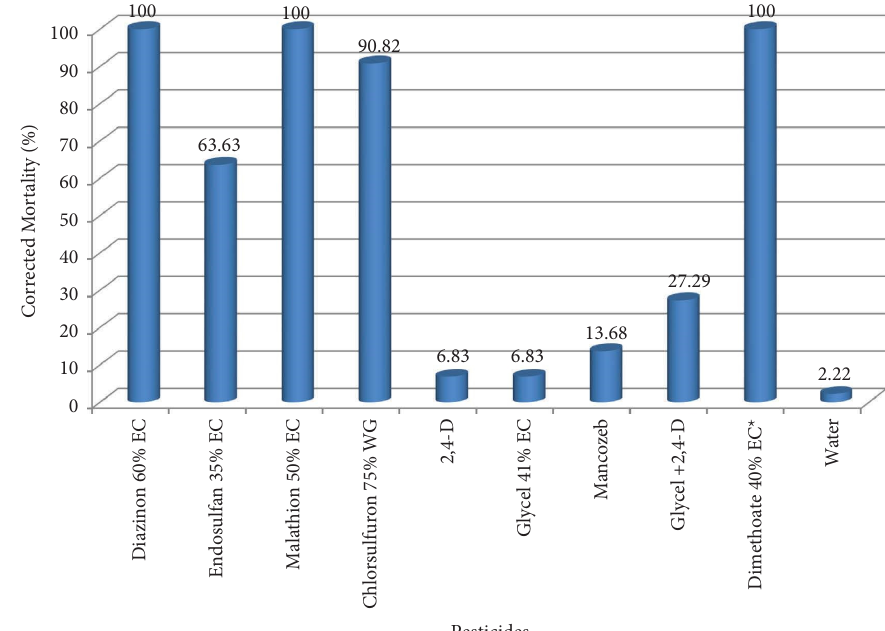
Figure 3: Mortality of local bees ( A. m. jemenitica ) tested via